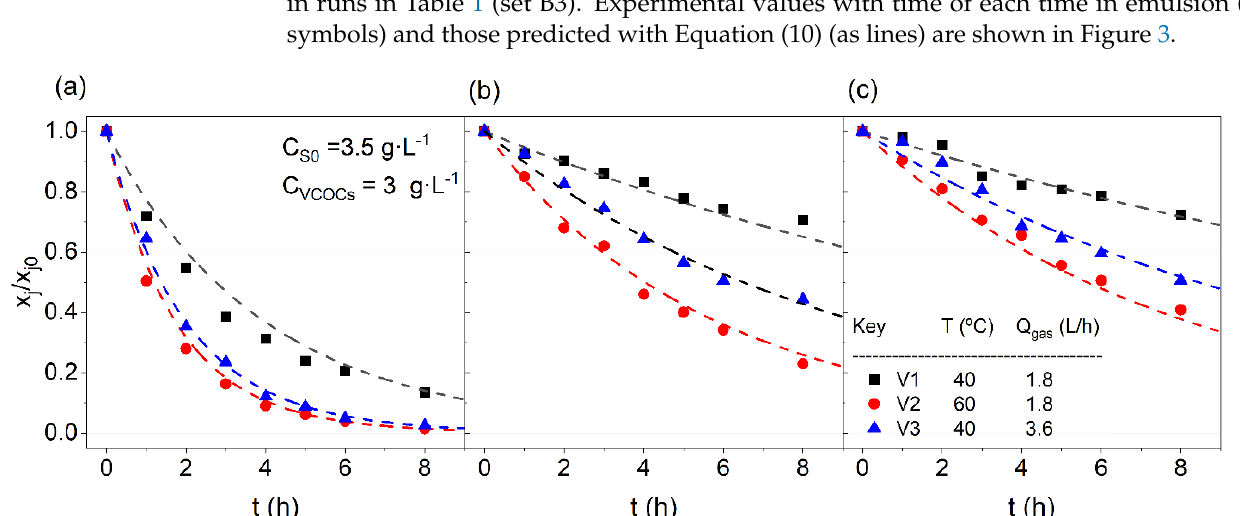
(Figure S1), reaching almost complete elimination